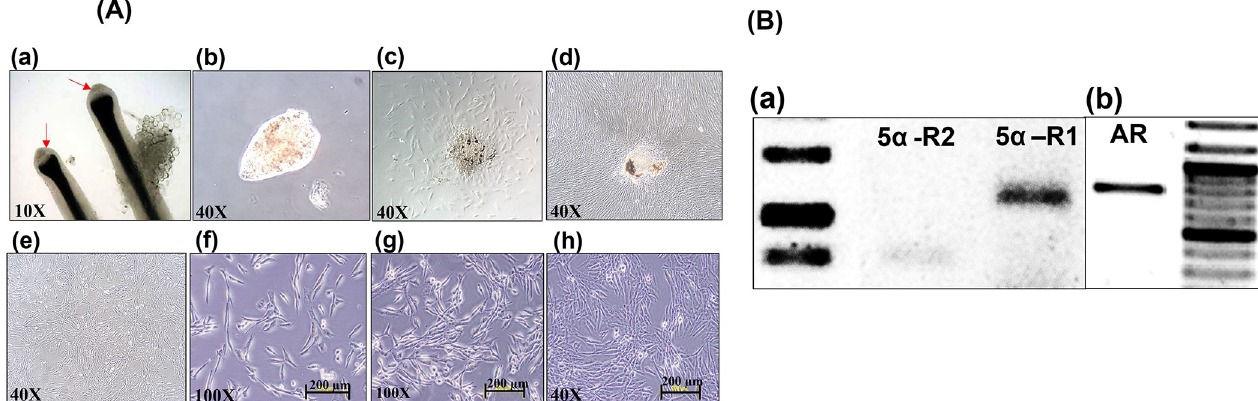
Fig 1. The culture characteristics of DPCs isolated from human hair follicles obtained by AGA patients. (A) (a) Intact hair follicle bulb (red arrows indicate the dermal papilla in the hair bulb region; 10 × ). (b) The pear-like shape of the typical membrane-bound DPCs (40 × ). (c) The initial outgrowth of isolated DPCs after 2 weeks of culturing (40 × ). (d) The isolated DPCs before full cell confluency after 1 month of culturing (40 × ). (e) The isolated DPCs at full cell confluency (40 × ). (f and g) The isolated DPCs at low cell density after culturing for 1 and 3 days, exhibiting a flatted and spindle-shaped morphology (100 × ). (h) The isolated DPCs forming multi-layered aggregations before reaching full confluency (40 × ). (B) RT-PCR showing the expression of target genes by DPCs. (a) The expression of 5 α -R1 (1,025 bp) and 5 α -R2 (801 bp) at passage 7. (b) The expression of AR (801 bp) at passage 5.